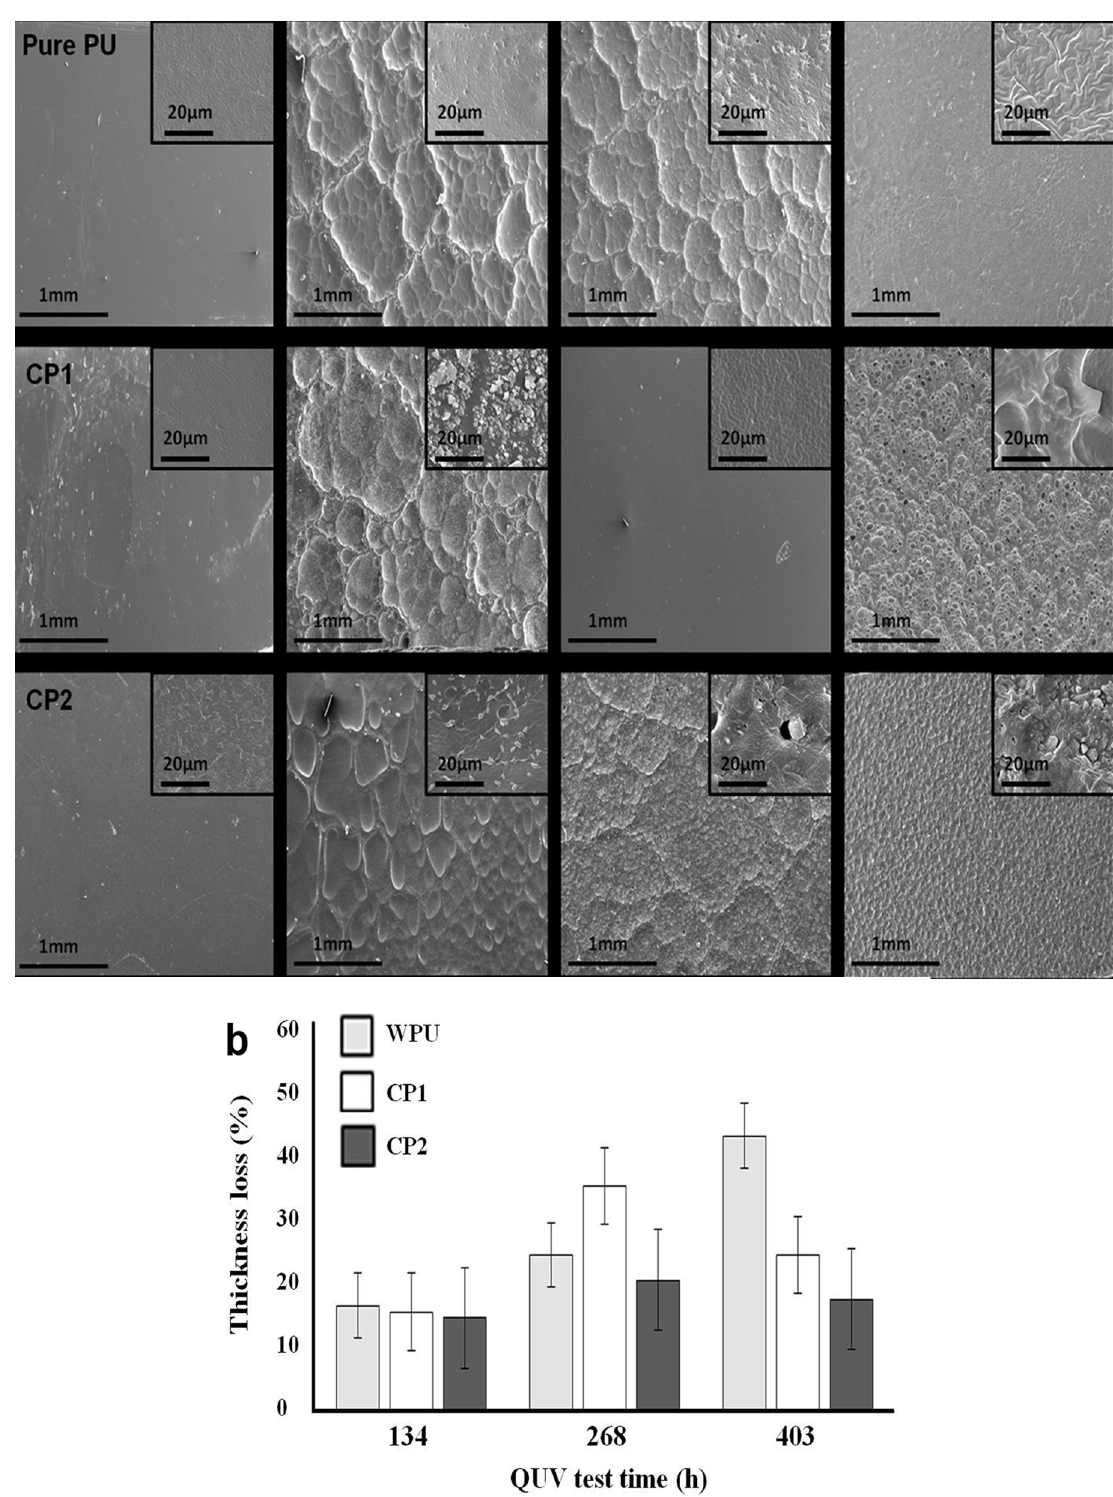
Figure 3 - ( a ) SEM micrographs of the samples exposed to the accelerated aging tests at a magnification of 100x; zoom at magnification 6000x and ( b ) Percentage loss of thickness of the films according to cycles of accelerated aging